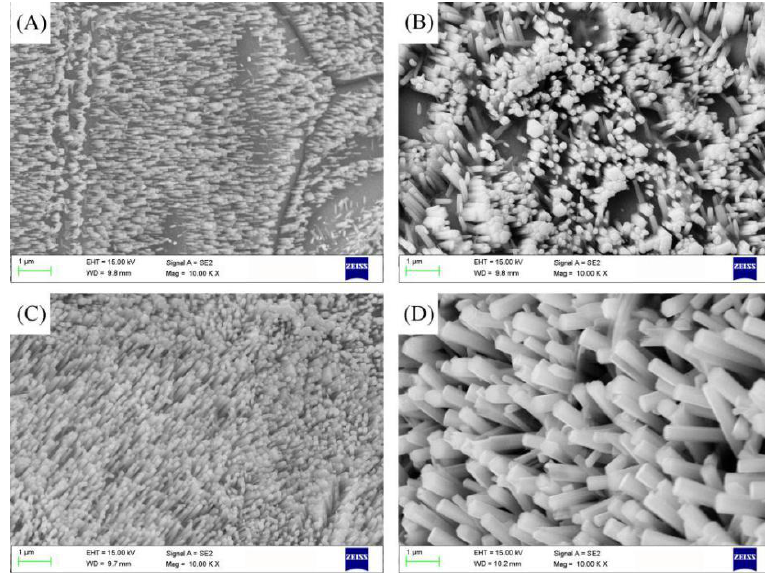
Figure 3. SEM image of ZnO at different reaction times: ( A ) 2 h, ( B ) 3 h, ( C ) 5 h, and ( D ) 6 h.